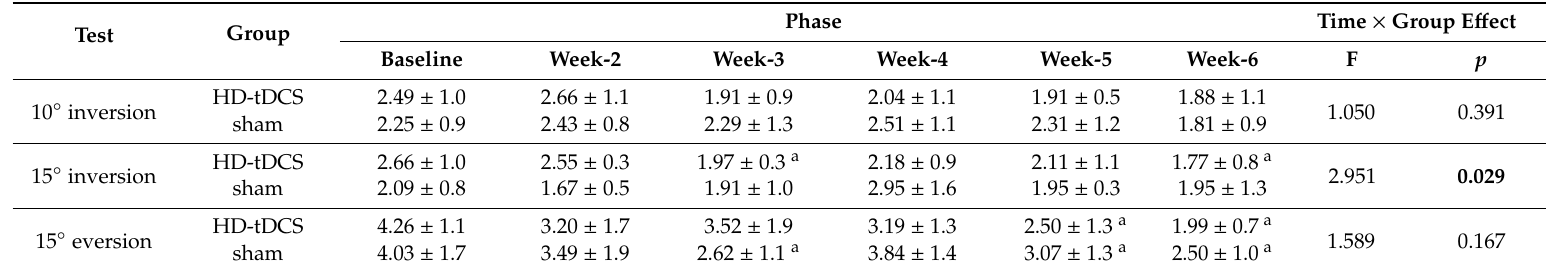
Table 2. Joint position reproduction performance (mean ±